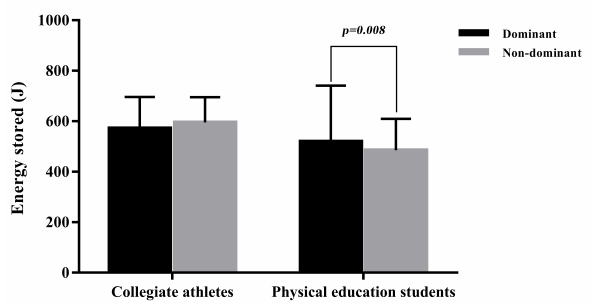
Fig. 2. Comparison of lower limb energy stored of dominant and non-dominant leg at